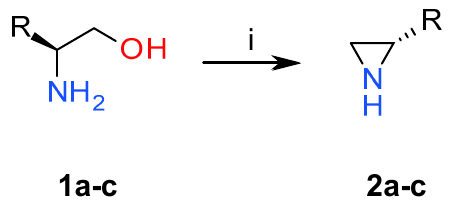
Figure 1. Reagents and conditions: (i) 1. ClSO 3 H, MeCN; 2. 5 M NaOH, reflux.